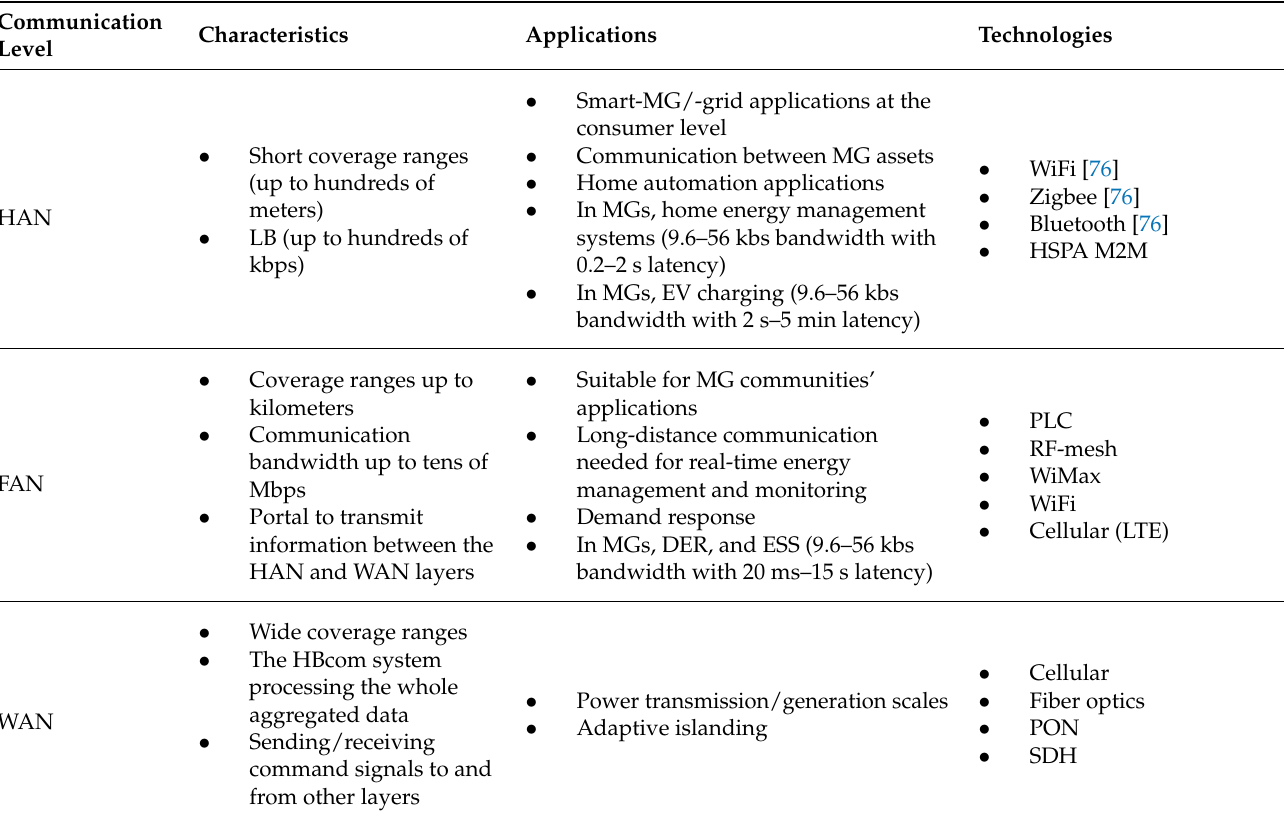
Table 10. Characteristics of HAN, FAN, and WAN and their applications in smart power